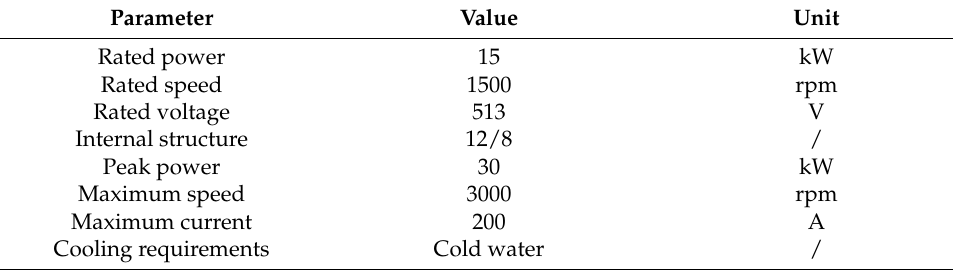
Table 4. The basic parameters of the motor.